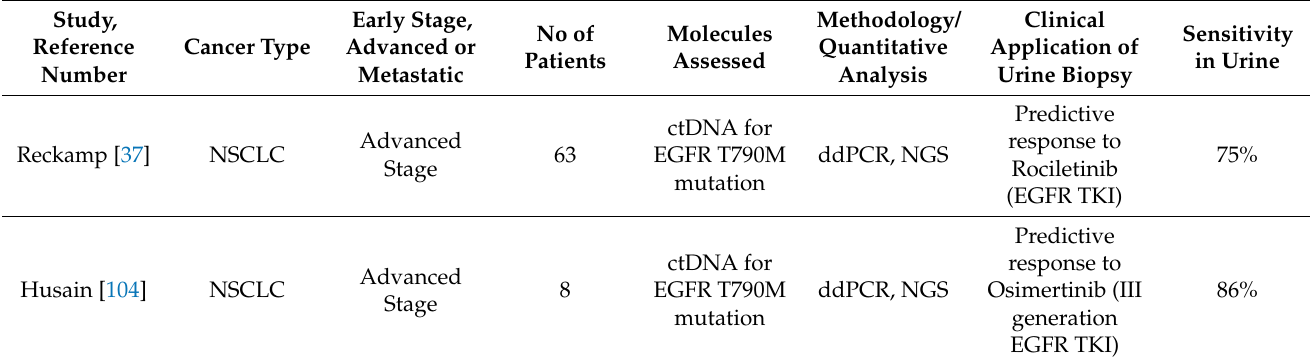
Table 2. Application of urine liquid biopsy in non-urological